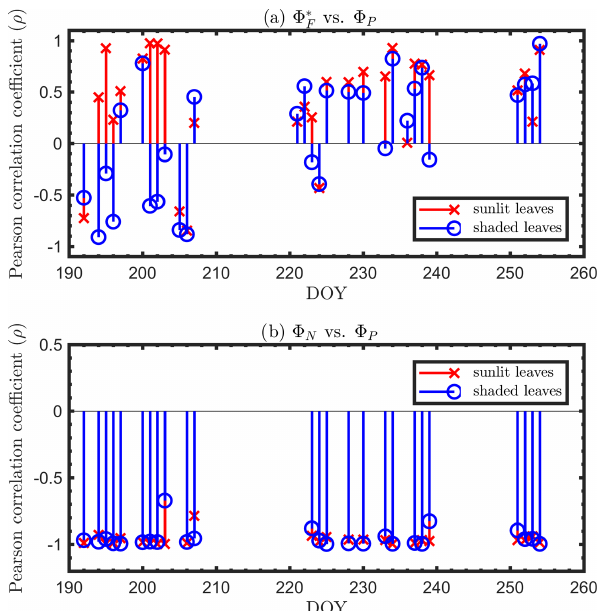
Figure 8. Diurnal correlations between (cid:56) ∗ (cid:56) N and (cid:56) P for sunlit and shaded leaves. The Pearson correlation coefficients for the days with more than five available observations are presented.